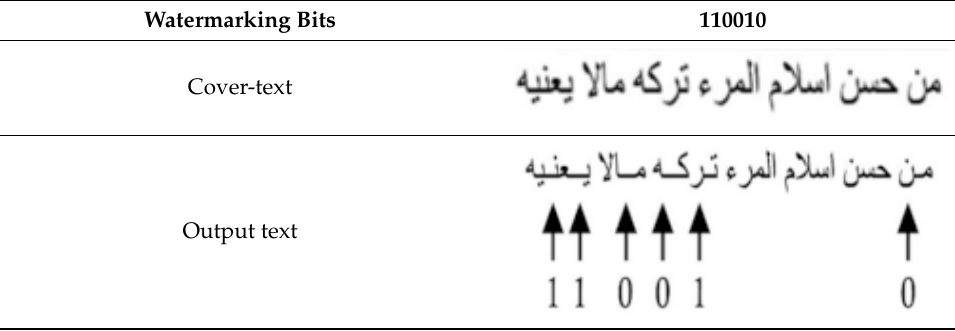
Table 11. A steganography example that adds extensions after letters (Adapted from